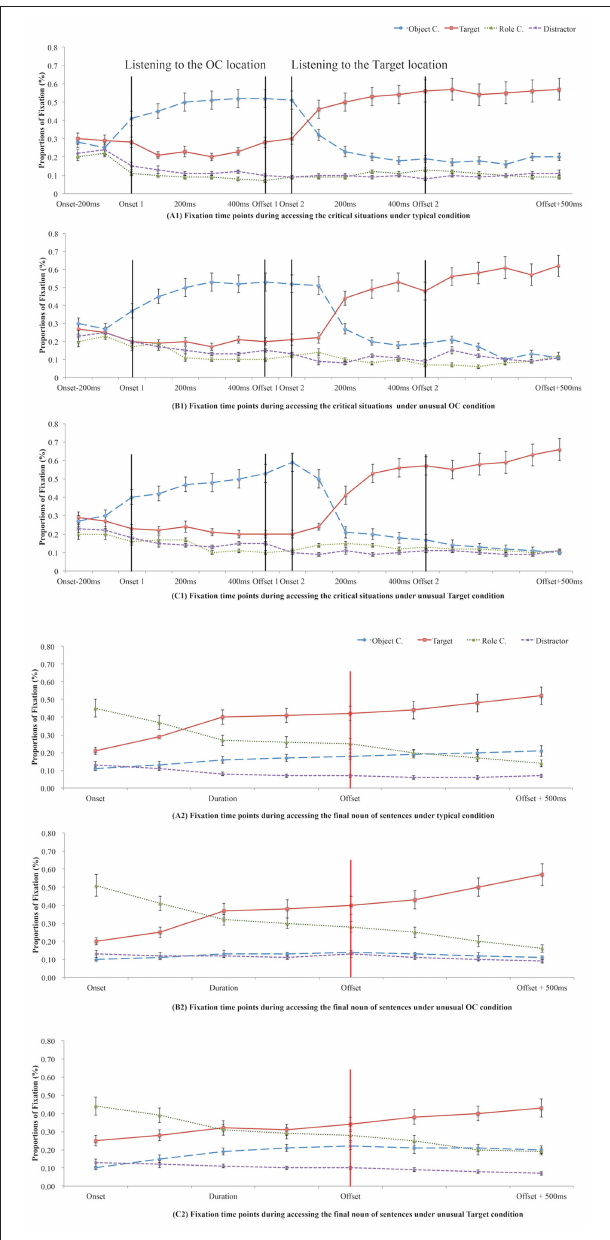
FIGURE 3 | Mean proportion of fixations while listening to the critical locations (OCs or Targets in A1, B1, and C1) or listening to the final noun of the sentence (retrieving Targets in A2, B2, and C2) in Experiment 2 under different conditions of appropriateness of word pairs’ coexistence (A, B, or C).